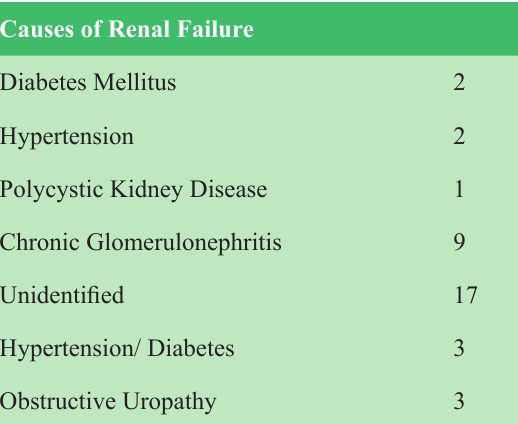
Table 1: Demographic Profile of Patients who underwent surgery for